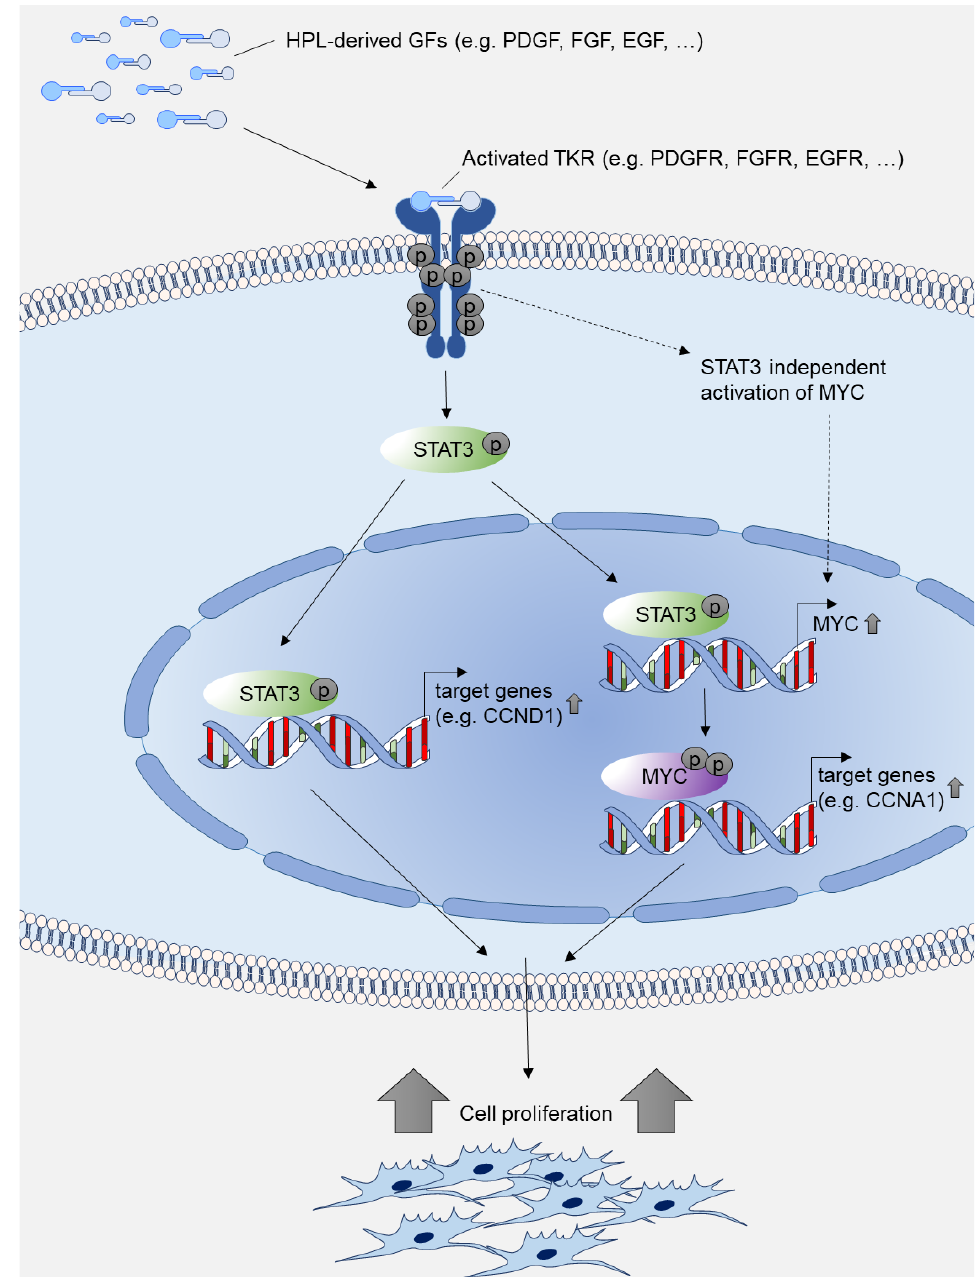
Figure 8. Model of HPL-mediated growth-promoting intracellular signal transduction. HPL-derived growth factors (GFs) such as PDGF, FGF and EGF activate tyrosine kinase receptors (TKRs) such as PDGFR, FGFR and EGFR. The activated signal results in increased expression of phosphorylated STAT3 and phosphorylated MYC, which further activate transcription of cell cycle target genes, thus promoting cell proliferation. Transcriptional activation of MYC may also be independent of STAT3 as described in [28,49,50].